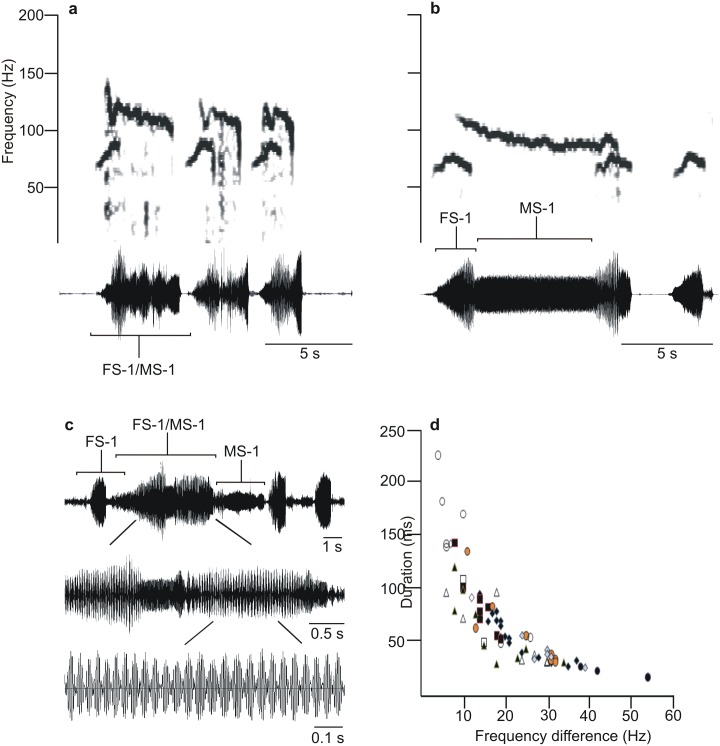
Sonagrams and oscillograms of overlapped FS-1 and MS-1 pulses of Eushistus heros that show a relation between interference pulse duration and frequency difference between masked signals.a, b: overlapped FS-1 and MS-1 pulses. c: overlapped FS-1 and MS-1 signals shown with different time axes. d: mean duration of pulses recorded in naturally emitted FS-1/MS-1 overlapped regions. Means were calculated for 10 different males with 2–7 MS-1 signals analyzed in each. Single mean duration values were calculated in 3 to 34 pulses within each signal. SD values were below 40% of the mean value. Regression (type power) equation: y = 814.16x-0.911, R2 = 0.8521.